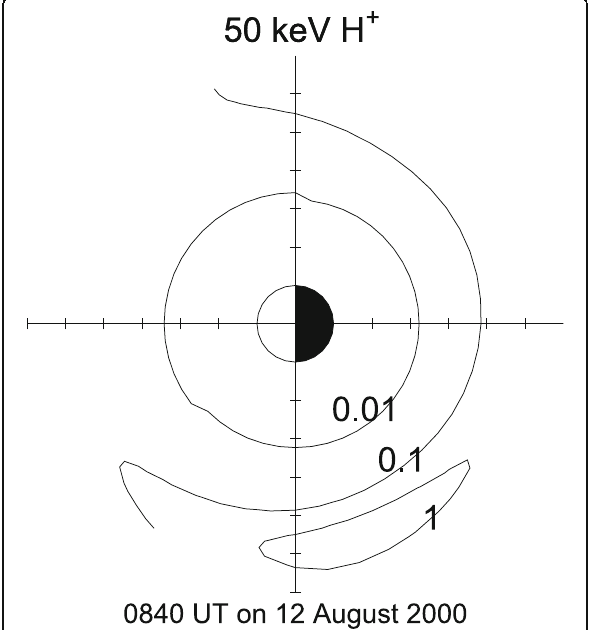
Fig. 5 The ratio of the gyroradius of protons with energy of 50 keV to the curvature radius of the magnetic field line for intense storm. (Ebihara et al. (2011)